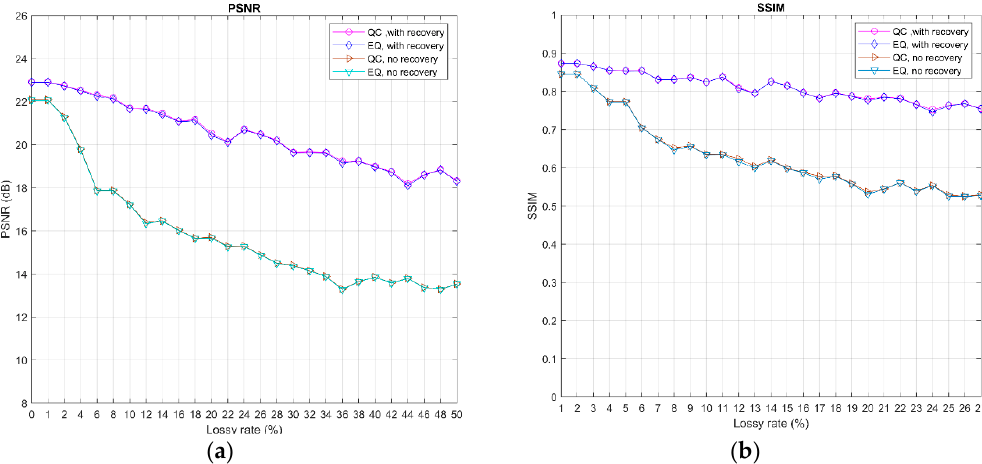
Figure 16. Reconstructions for EQ and QC constraints for Pasadena-houses with different lossy probabilities: ( a ) PSNR curves and ( b ) SSIM curves.